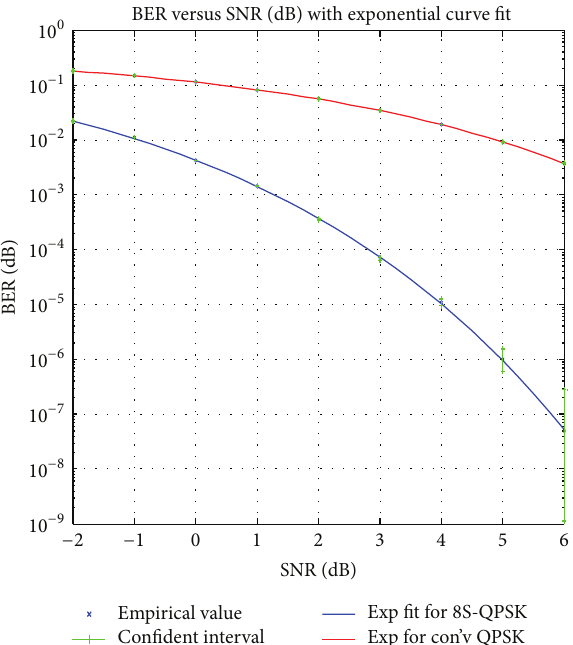
Figure 4: Performance comparison of 8S-QPSK and conventional QPSK scheme in additive white Gaussian noise (AWGN) channel with confidence interval and empirical value.